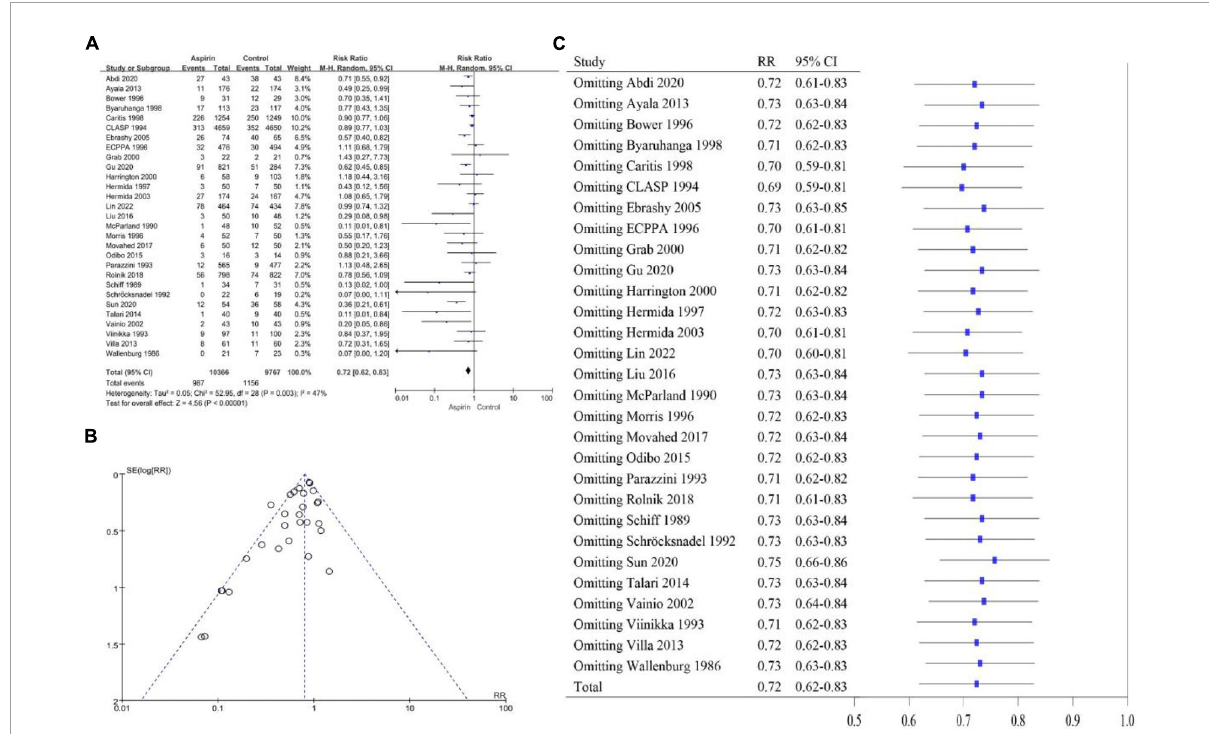
FIGURE2 (A) Forest plot of studies on the effect of aspirin on the development of PE in women at high risk for PE. (B) Funnel plot of the studies on women at high risk for PE. (C) Sensitivity analysis of the included